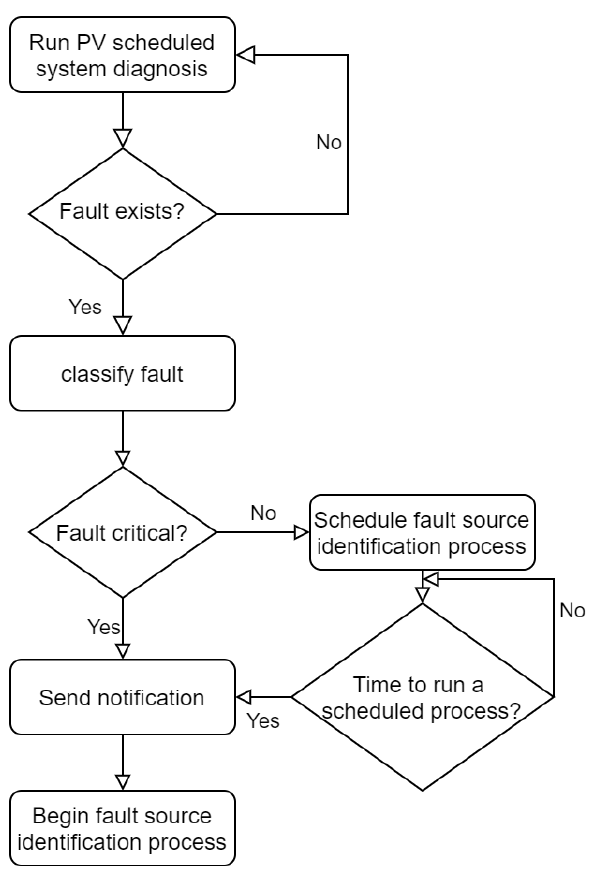
Figure 6. Flow chart showing the general operations in the tree search fuzzy NARX fault detection Flow chart showing the general operations in the tree search fuzzy NARX fault technique. detection